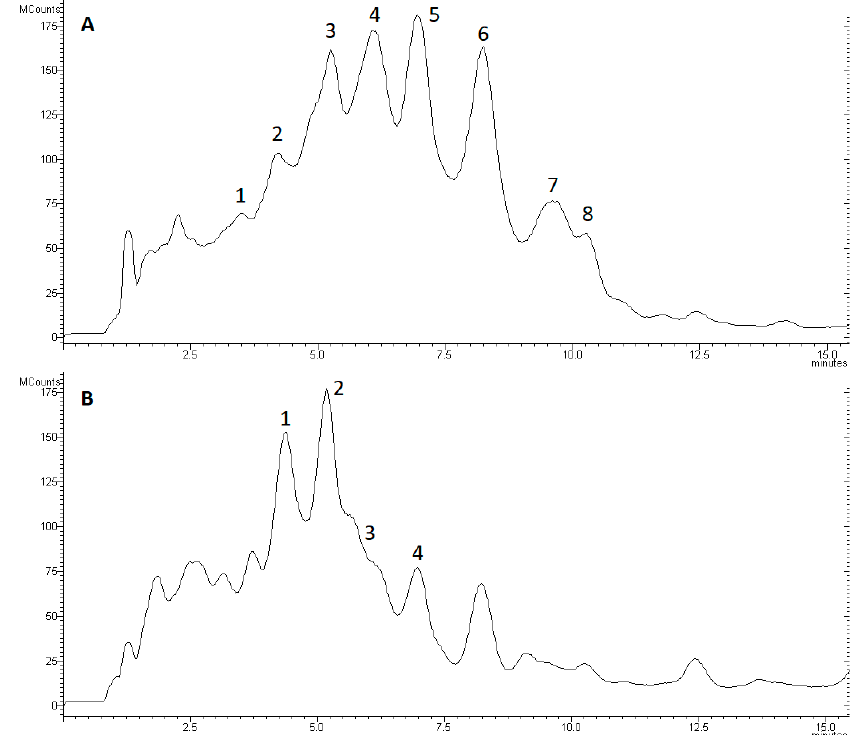
Figure 6. Total ion chromatogram of peptaibols extracted from ( A ) Trichoderma asperellum IRAN 3062C and ( B ) Trichoderma longibrachiatum IRAN 3067C. Kromasil C18; 5 µ m, 1.6 × 250 mm; MeOH / H 2 O (86:14), flow rate 1 mL min − 1 . Numbers indicate peaks containing peptaibols (see Table